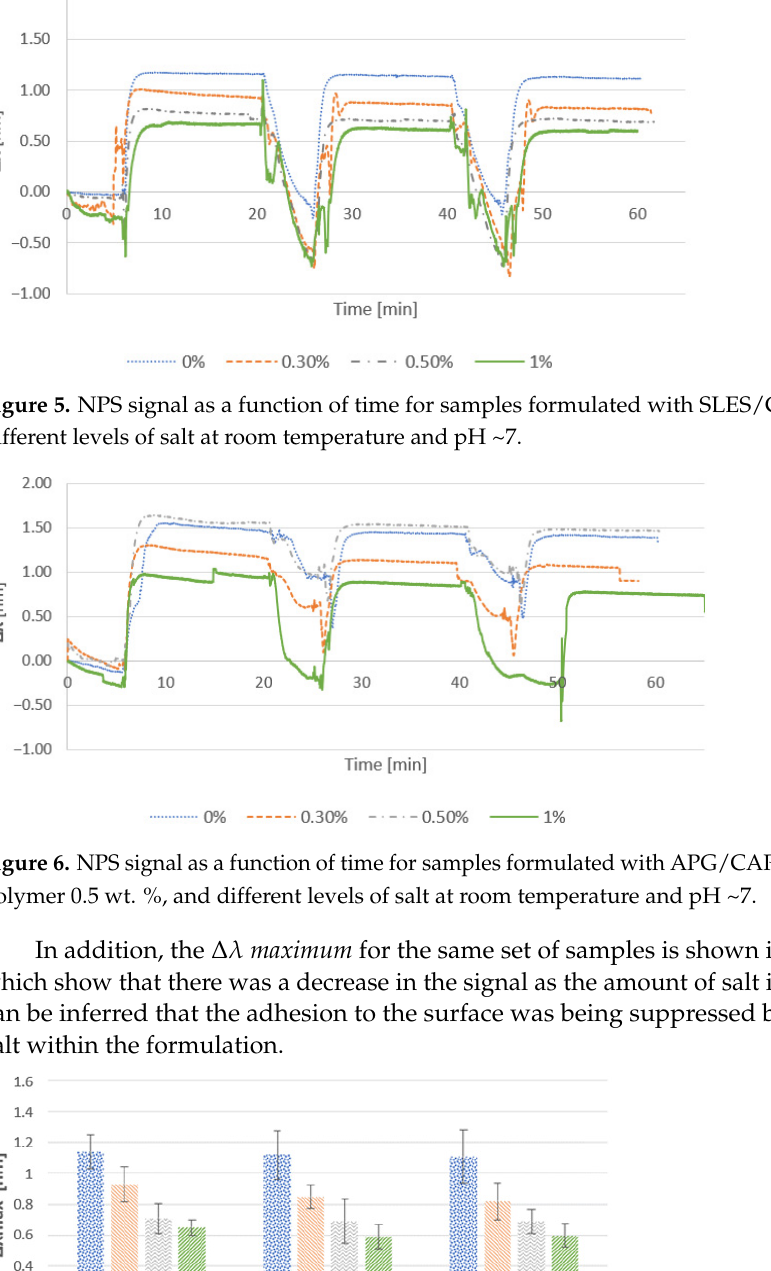
Figure 7. Δλ maximum for samples formulated with SLES/CAPB 12 wt. %, cationic polymer 0.5 wt. %, and different levels of salt at room temperature and pH ~7.